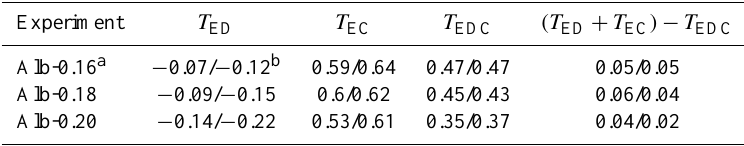
Table 2. Changes in annual mean global and NH temperature ( ◦ C).